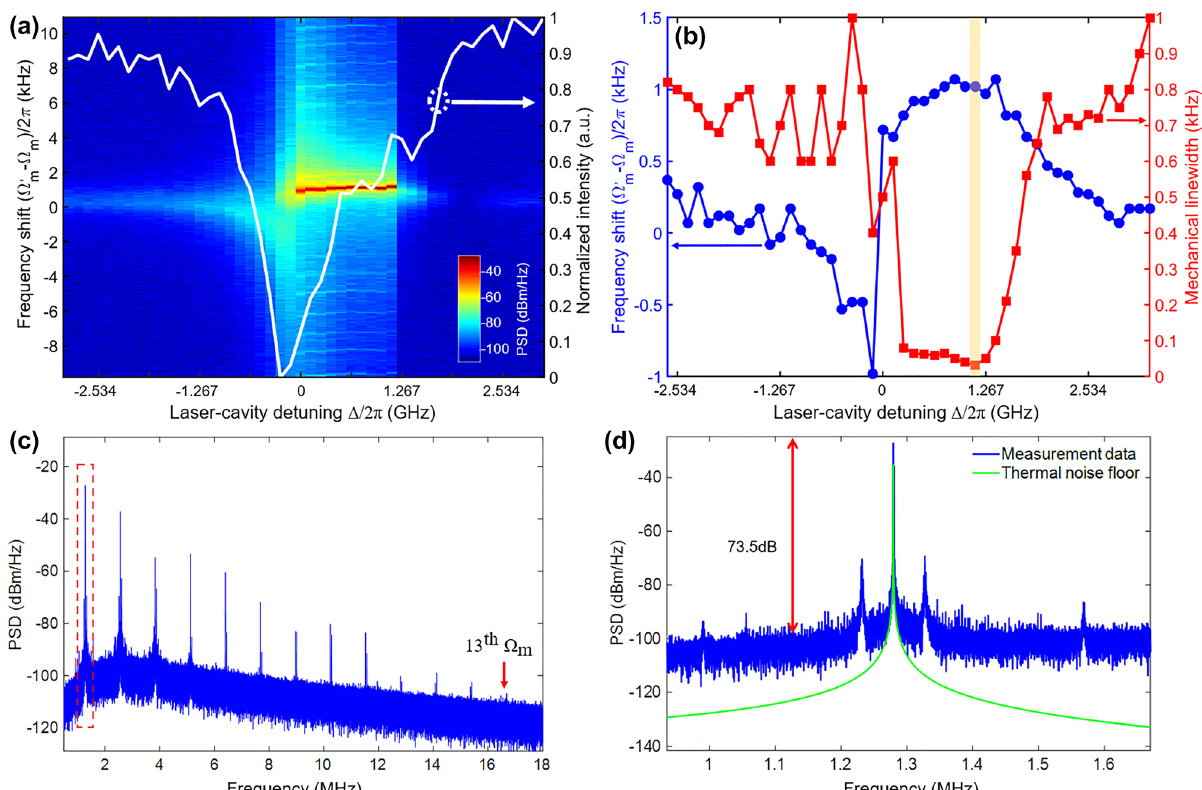
Figure 7: Optomechanical backaction RF spectra above threshold power. (a) PSD map of the measured RF spectrum as functions of laser-cavity detuning to verify and mechanical resonance shift from the in-plane fundamentalmodeabovethethresholdpower.Atthepumppowerof180 μ W,theRFspectrumisobtainedbysweepingthroughthecavityTE 1,e resonance as the white-colored curve. (b) Mechanical resonant frequency shift and mechanical linewidth versus laser-cavity detuning at the pump power of 180 μ W. The light-yellow region indicates the operation position of the pump light for bias voltage detection. (c) RF harmonics oftheoptomechanicalcavityabovethethreshold,uptothe13thharmonicat16.7MHz.TheRBWis100Hz.(d)Zoom-inviewofthespectrumin the red-dashed box of Figure 7(c). The RBW is 1 Hz to characterize the RF spectrum. The green-colored curve is the theoretically calculated thermal noise fl